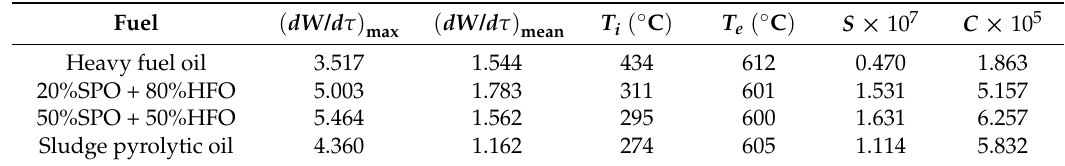
Table 9. The combustion characteristic parameters of sludge pyrolytic oil, heavy fuel oil, and the blends. ( dW / d τ ) Fuel ( dW / d τ ) max mean Heavy fuel